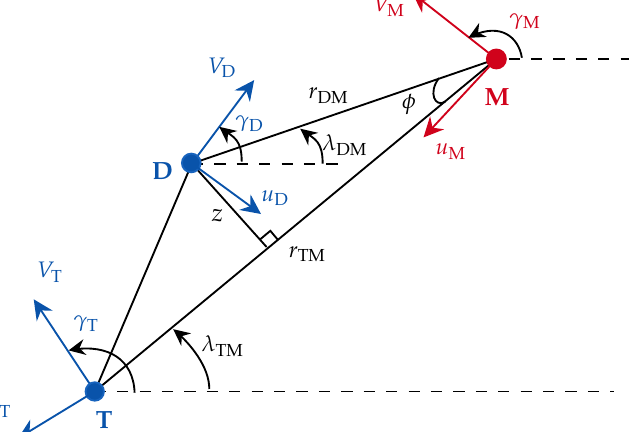
Figure 1. Three-body engagement